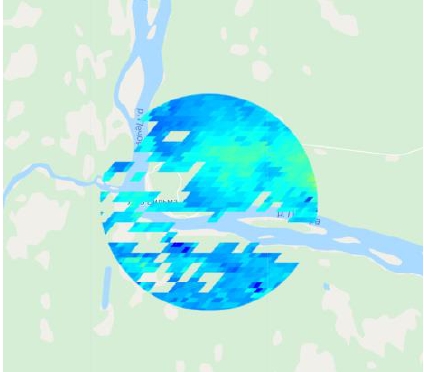
Figure 3. NDWI map for the 10 km buffer zone around the Ust- Tsylma meteorological station with a cloud mask effect (2000- 03-01) The fourth step is to compute the average NDWI value for each buffer zone. All the steps are repeated for every MOD09GA dataset to produce annual graph of the NDWI for the selected meteorological station. Produced graphs are compared with the graphs of daily averaged surface air temperature to find the similar days of the beginning and ending the growing